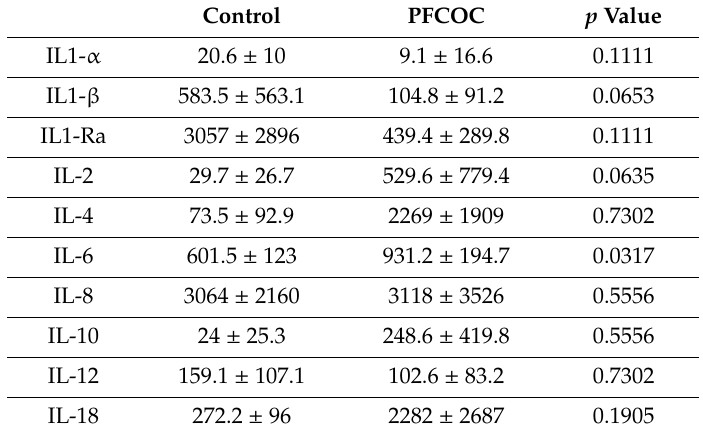
Table 3. Bronchoalveolar lavage (BAL) cytokine levels at the end of 4 h reperfusion after transplantation. Control